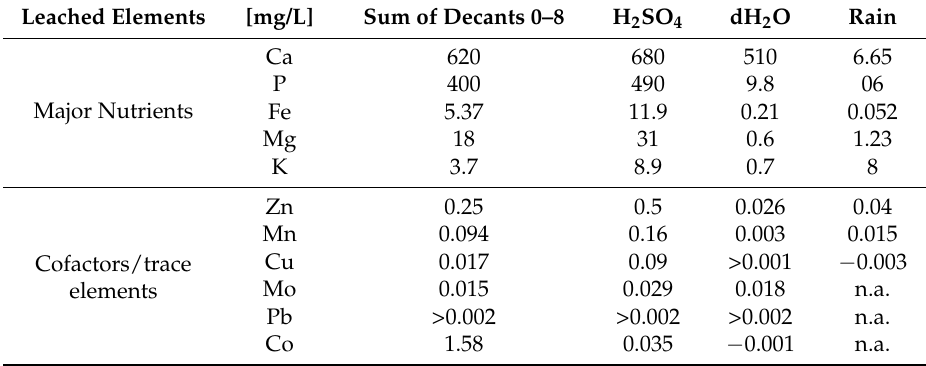
Table 4. Release of elements from 10 g CPMW after stirring in 0.1 M sulphuric acid, distilled water or rain